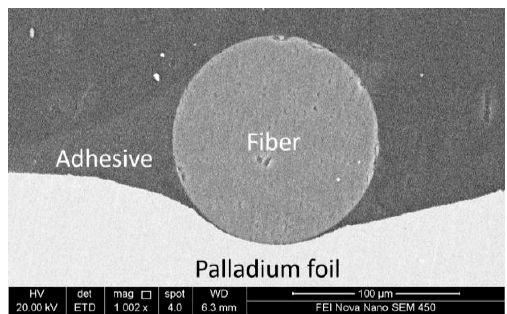
Figure 1. SEM image of a palladium foil based FBG sensor.